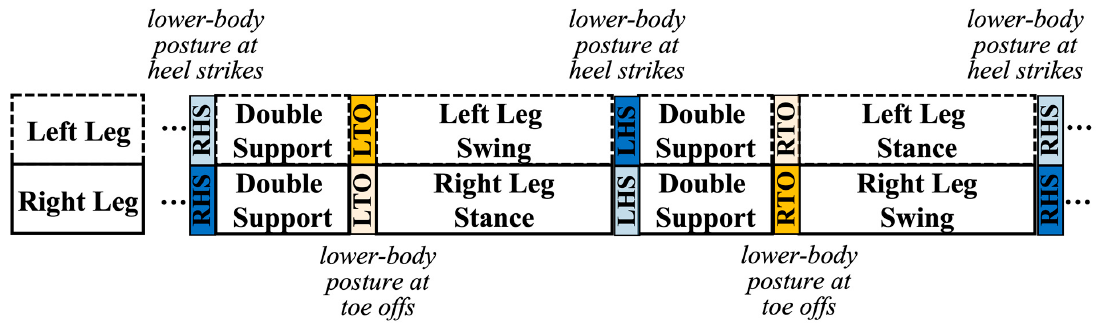
Figure 4. The posture of the moving leg at heel strikes (dark blue), of the anchoring leg at heel strikes (light blue), of the moving leg at toe offs (dark yellow), and of the anchoring leg at toe offs (light yellow).